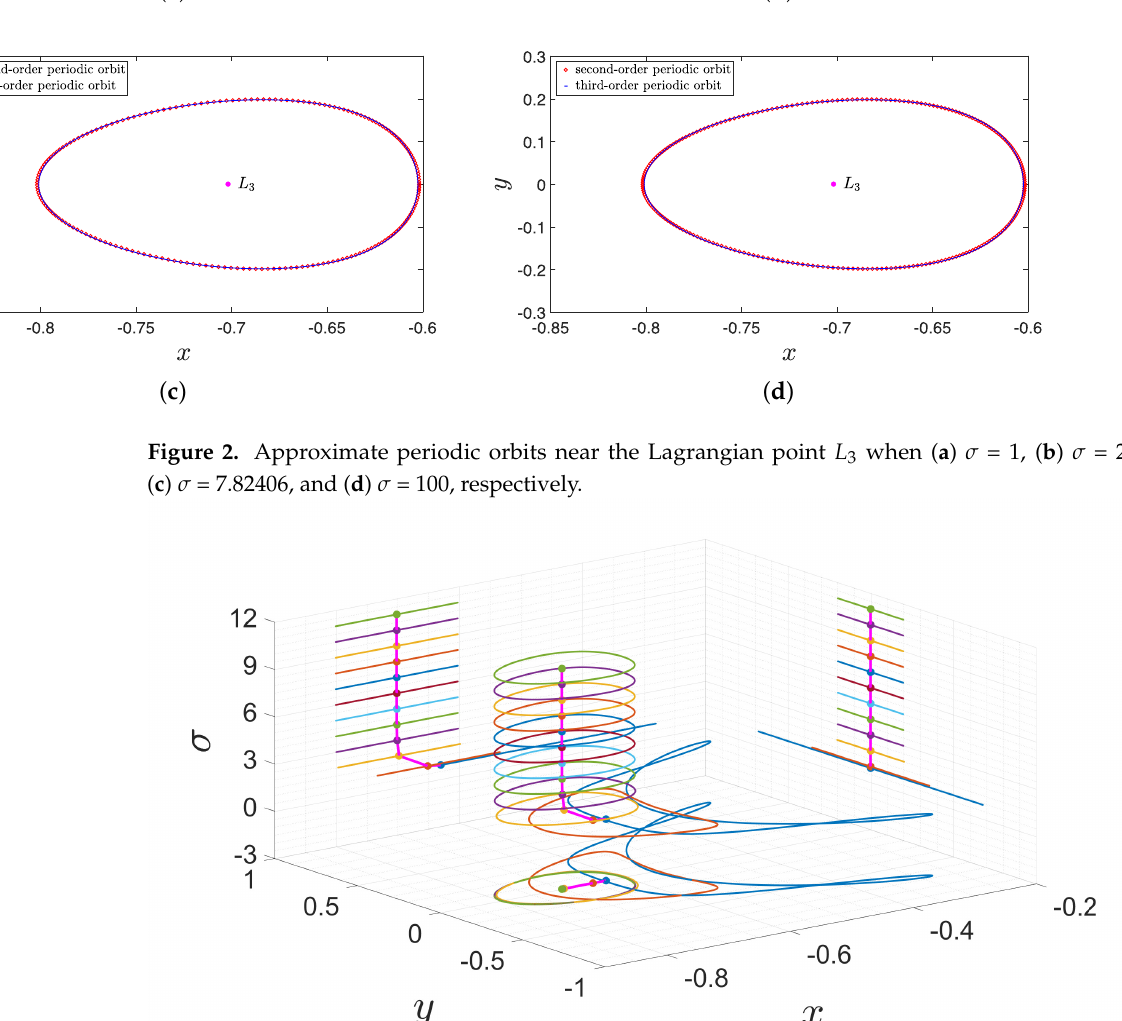
Figure 3. Third-order periodic orbits and their planar projections under different σ -values. When the scale parameter σ located on the denominator of the potential energy function decreases, we found that the shape of the periodic orbits becomes complicated, as shown in Figures 2 and 3. With the increase in σ in Figure 3, the shape of the third-order approximate periodic orbit hardly changes, the position of Lagrangian point L 3 gradually moves away from the center-of-mass and then stays near ( − 0.7018, 0 ) , and the periodic orbit in the directions of x and y finally stabilizes in the area of ( − 0.8, − 0.6 ) × ( − 0.2, 0.2 ) . The range of σ is limited to the confidence interval [ 6.05109, 11.0738 ] . In this case, we